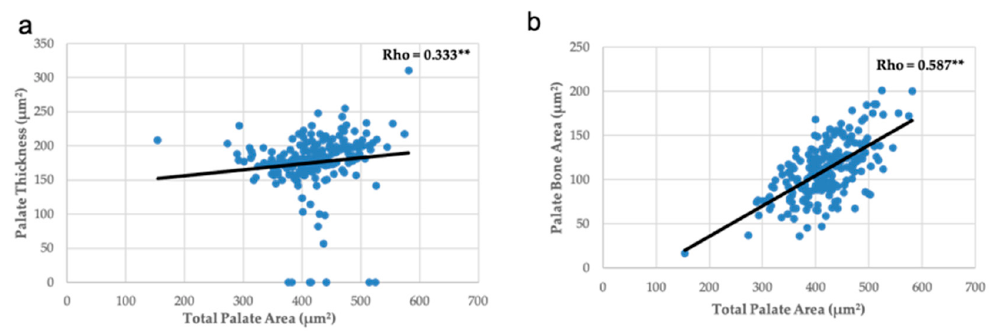
Figure 7. Correlations between palate measurements and total palate area. ( a ) Palate thickness and ( b ) palate bone area. ** p ≤ 0.01; Spearman’s Rho.